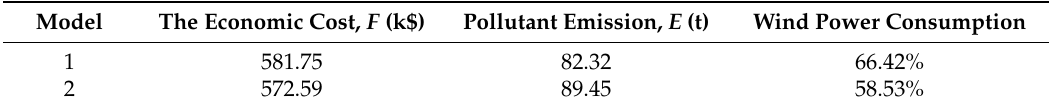
Table 4. Scheduling results for different models.